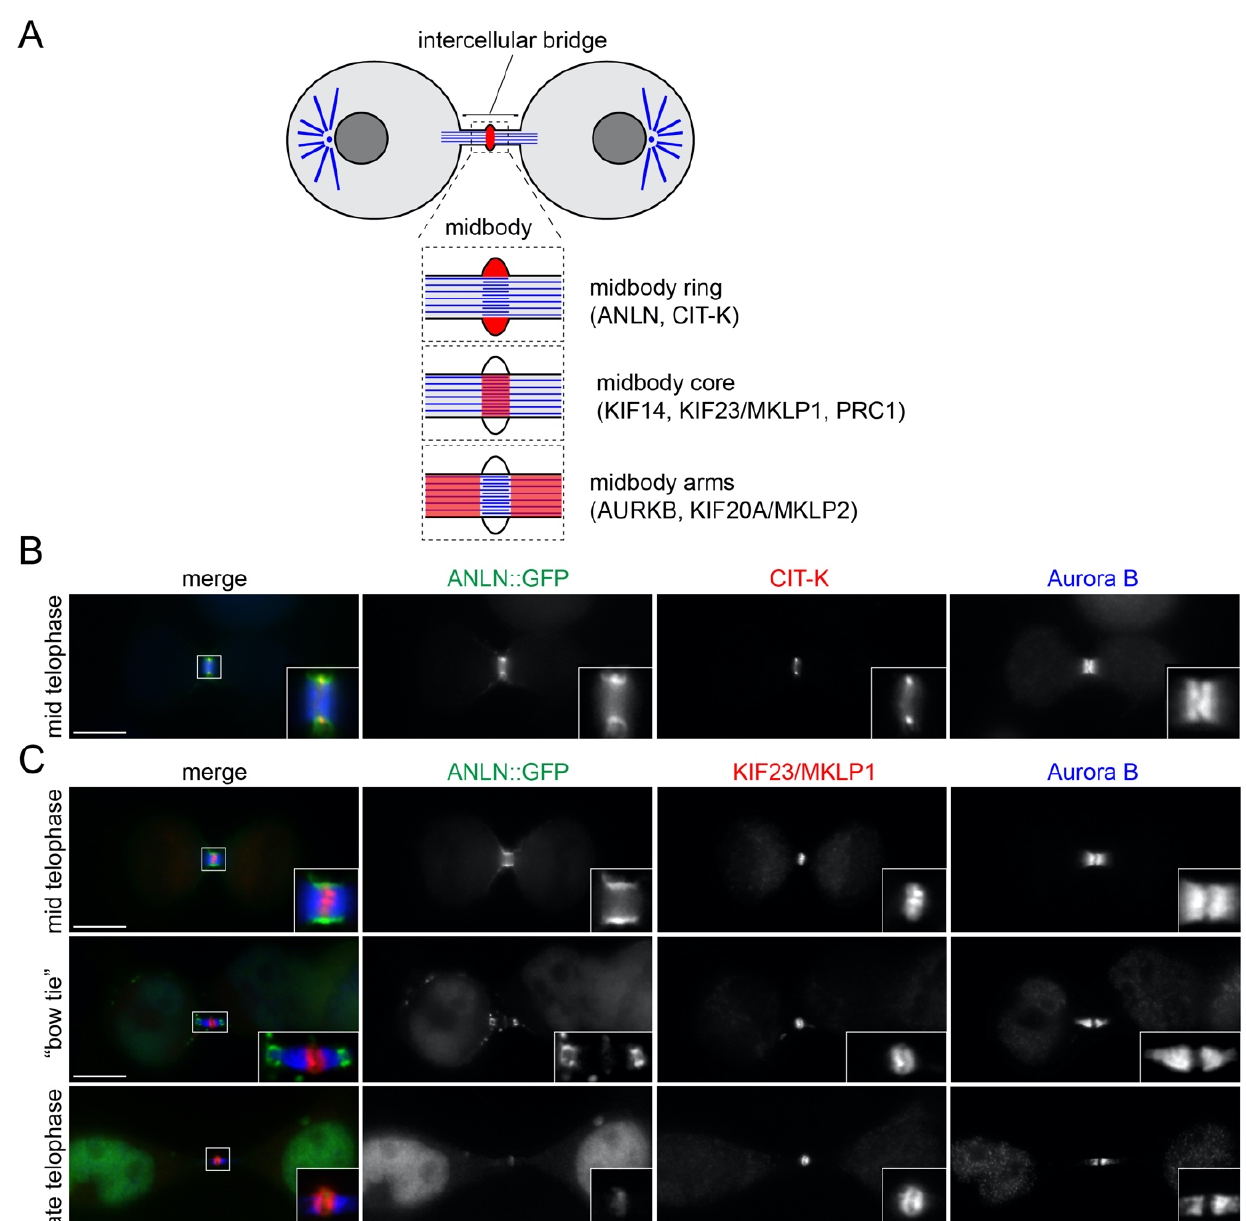
Figure 1. Changes in the distribution of midbody proteins during its maturation. ( A ) Schematic diagram of the midbody showing its different regions and the localization of the proteins analyzed in this study. ( B , C ) HeLa cells expressing ANLN::GFP were fixed and stained to detect GFP (green in the merged panels) Aurora B (blue in the merged panels) and either CIT-K (red in the merged panel in B ) or KIF23/MKLP1 (red in the merged panels in C ). Insets show a 3× magnification of the midbody. Bars, 10 µm.